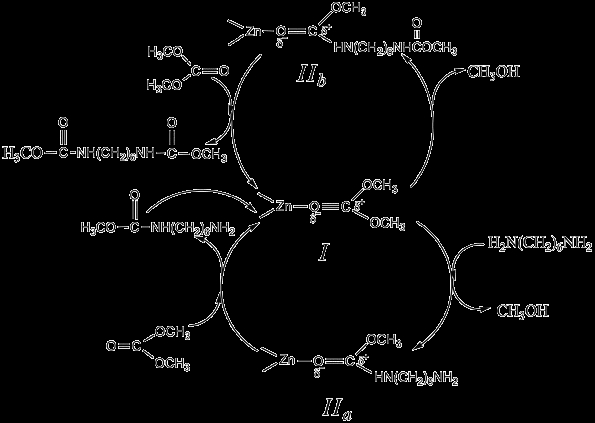
A proposed mechanism for the methoxycarbonylation of 1,6-hexanediamine with DMC over ZnAlPO4.